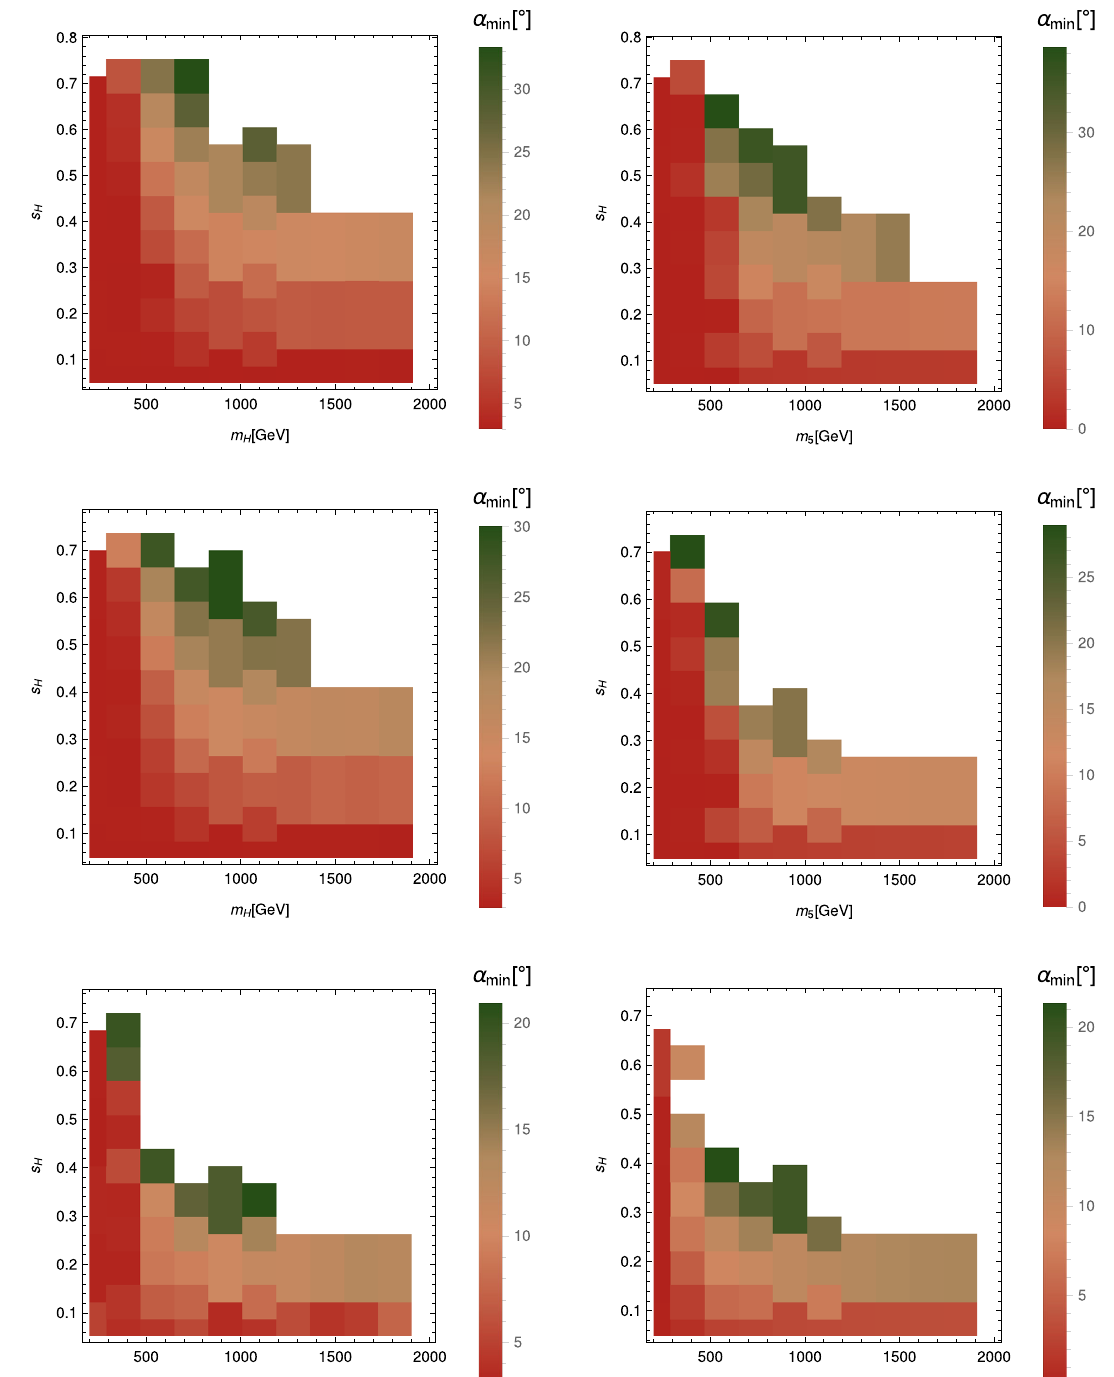
Fig. 16 Results of the parameter scan. First row: the minimal value of α found in the ( m H , s H ) -plane for Input I (left) and the ( m 5 , s H ) - plane for Input II (right). In the second row, we show the same figures